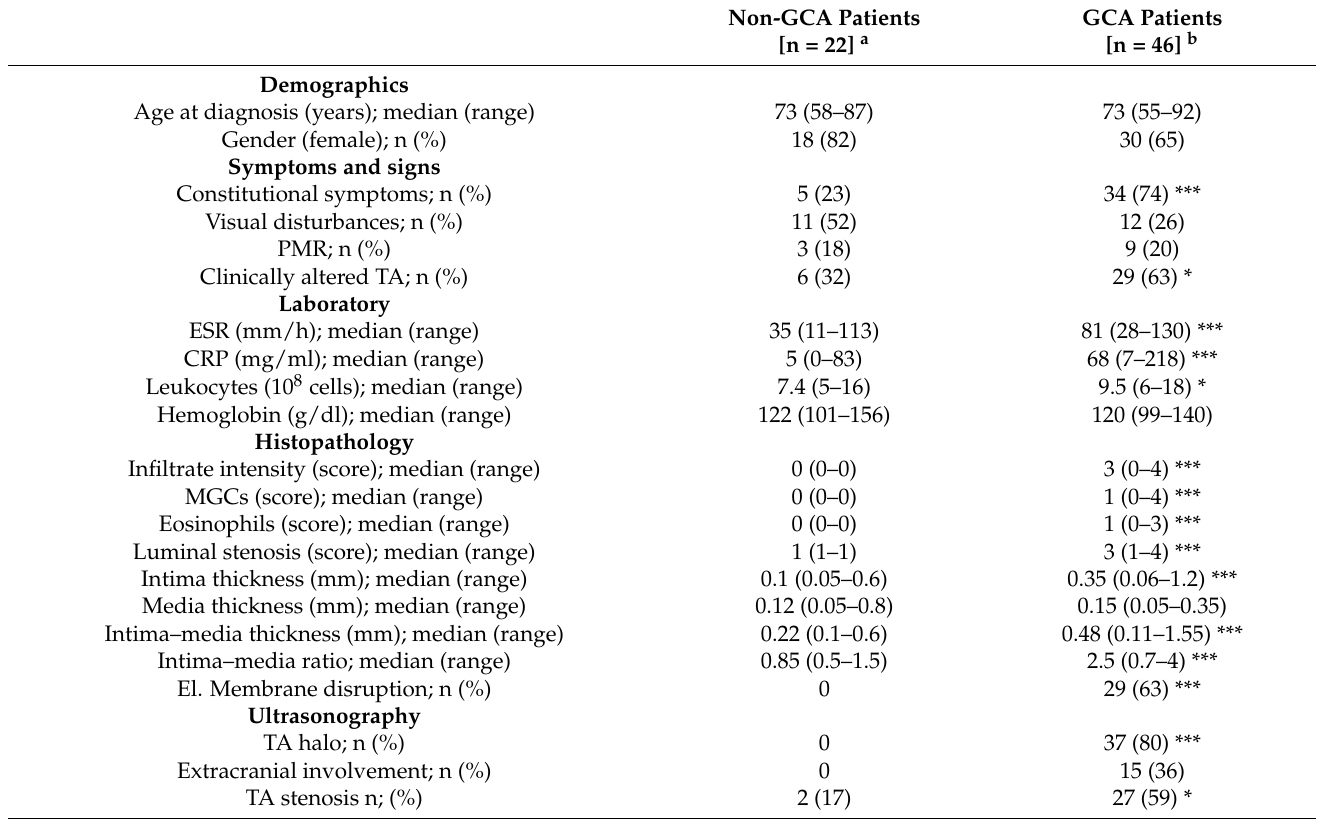
Table 1. Patient characteristics for each set of diagnostic